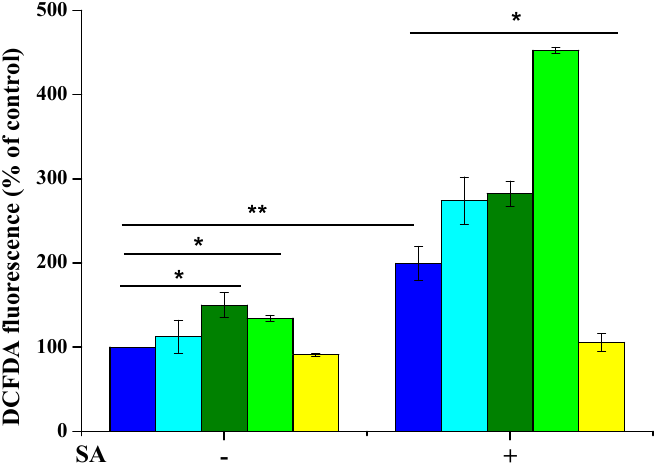
Figure 9. Determination of intracellular ROS levels by DCFDA assay on HaCaT cells. Cells were preincubated in the presence of 1.3 nM CeO 2 _OL_250 (yellow bars), 7.3 µM oleylamine (light blue), 7.1 µM sodium oleate (dark green bars), and a mixture of oleylamine and sodium oleate (light green bars) for 2 h, prior the induction of oxidative stress. Blue bars are referred to untreated cells in the absence ( − ) or in the presence (+) of 300 µM sodium arsenite (SA). Values are expressed as percentage with respect to control (i.e., untreated) cells. Data shown are means ± S.D. of three independent experiment. * indicates p < 0.05, ** indicates p < 0.005.